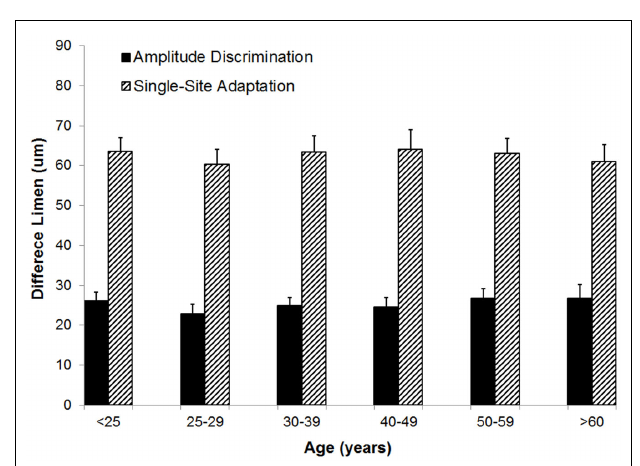
FIGURE 5 | Comparison of difference limen obtained with amplitude discrimination tasks with or without single-site adaptation. There is no significant difference in means across six age groups for both the metric of amplitude discriminative capacity ( p = 0.85) as well as the adaptation metric ( p =